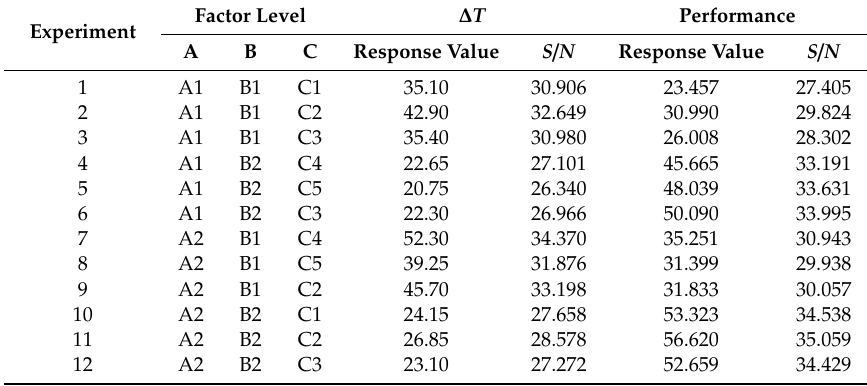
Table 3. The process response and signal-to-noise ( S / N ) values for the Taguchi design of the solar air